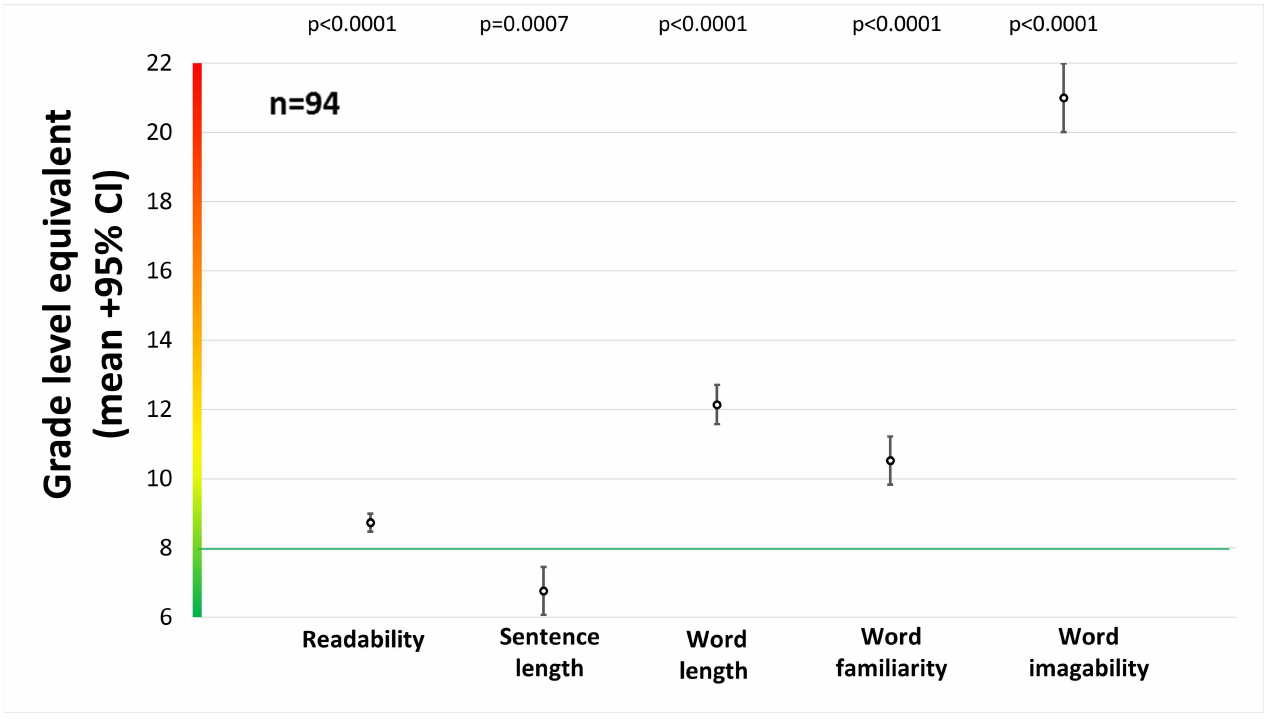
Fig 2. Average grade level equivalents for all language